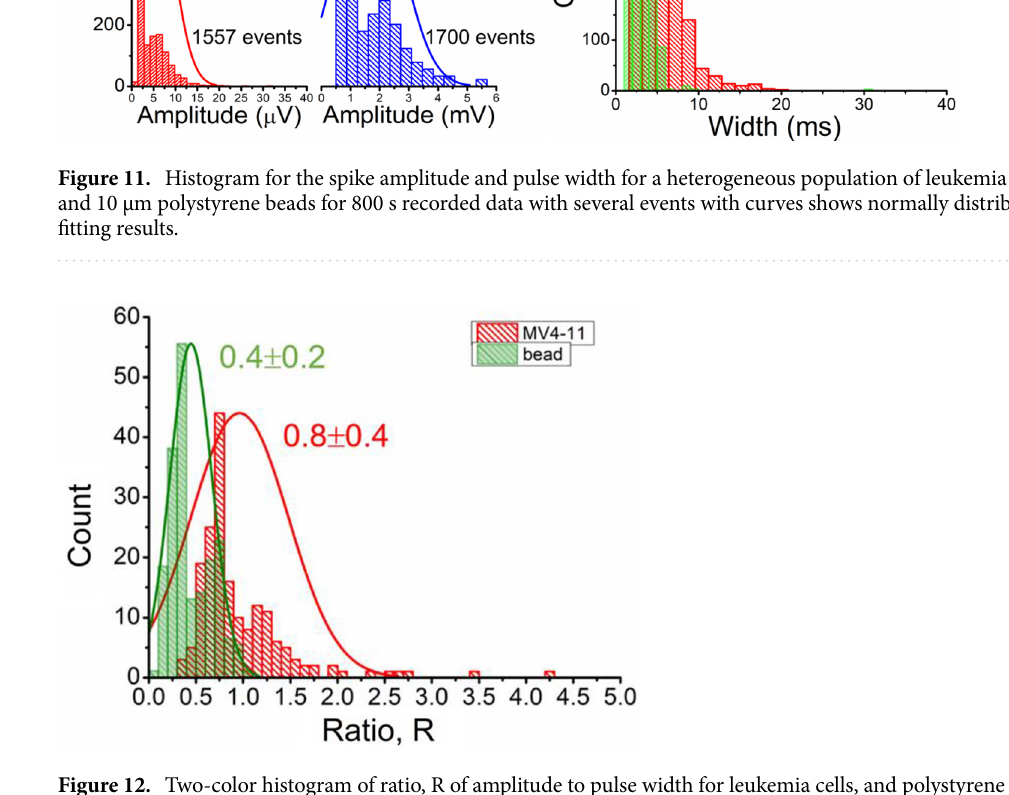
Figure 12. Two-color histogram of ratio, R of amplitude to pulse width for leukemia cells, and polystyrene beads with fitted normal distribution. Each histogram’s average value and standard deviation are